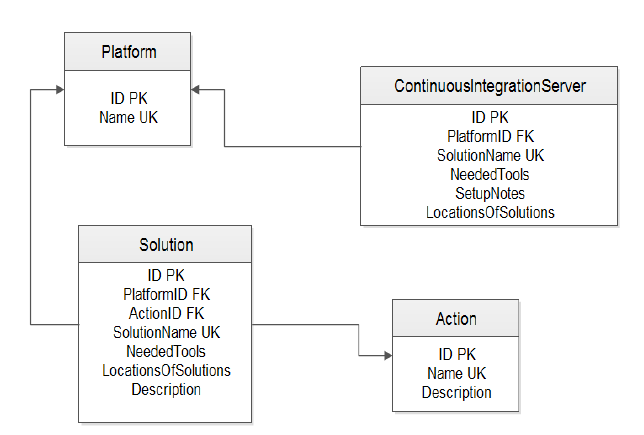
Fig. 2. Structure of Solution